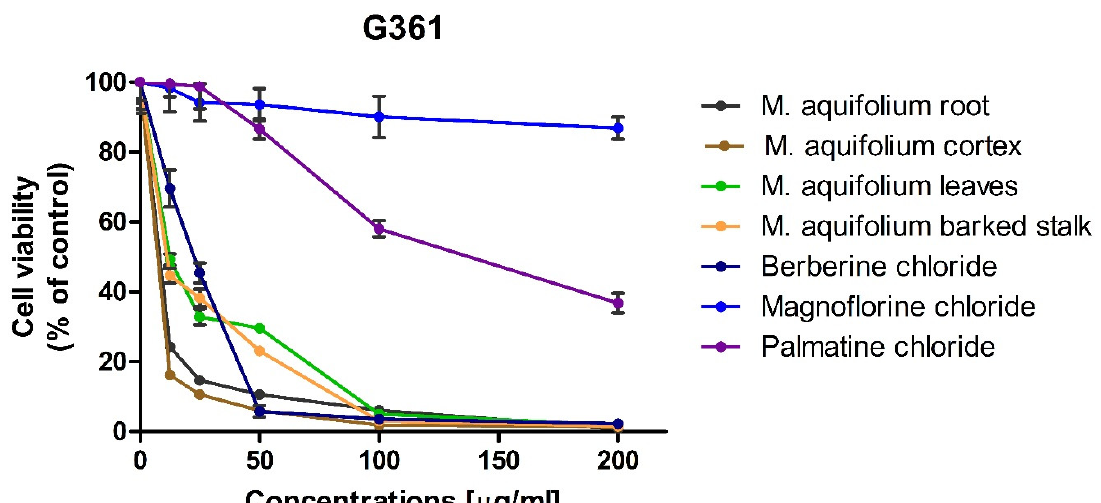
Figure 9. Effect of alkaloid standards and Mahonia aquifolium extracts on the viability of human melanoma G361 cells.